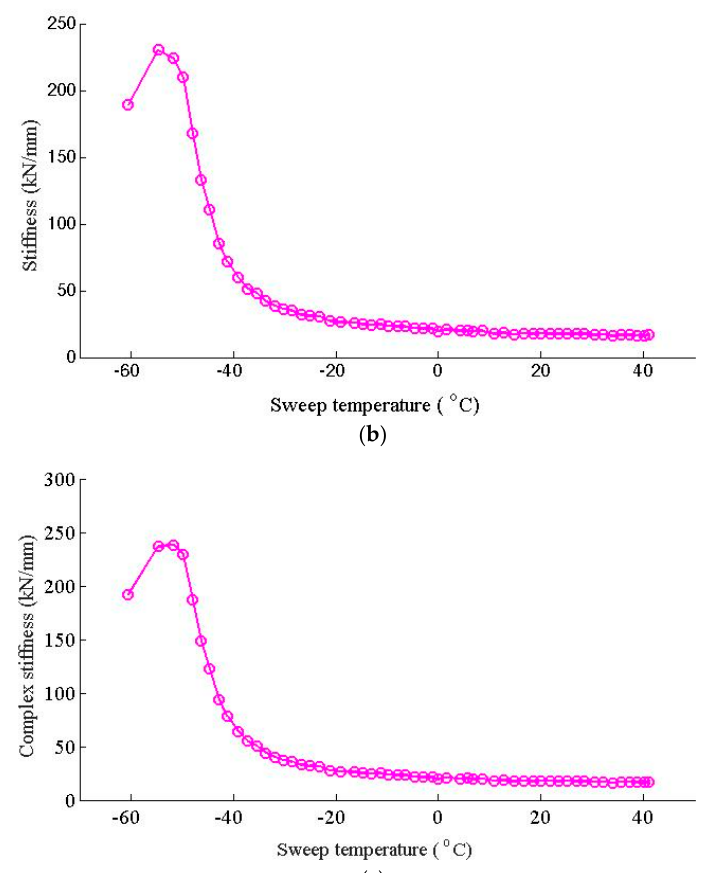
Figure 6. Mechanical parameters of WJ-7B small resistance fastener rubber pad: ( a ) Young’s modulus, ( b ) stiffness, ( c ) complex stiffness.